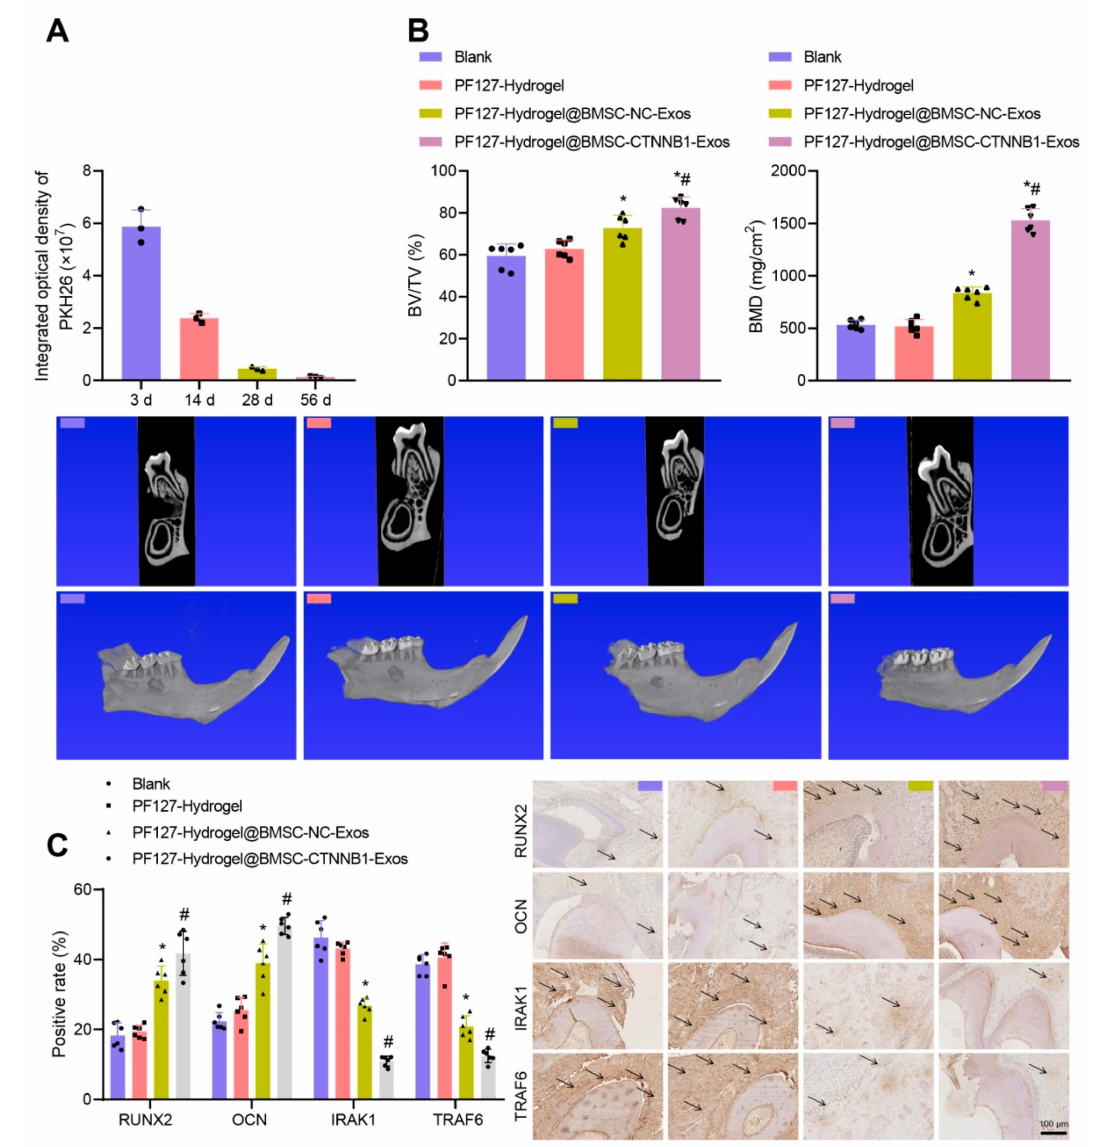
Figure 8. PF127 hydrogel loaded with BMSC-CTNNB1-Exos induces the alveolar bone regeneration in rats. ( A ) In vivo TPEF recording of the distribution of PKH26-labeled Exos implanted at different time points and quantitative analysis. n = 3. ( B ) The micro-CT scanning images focusing on the second mandibular molar (red frame) and the quantitative results of alveolar bone defects in rats treated with PF127 hydrogel@BMSC-CTNNB1-Exos. n = 6. ( C ) The positive expression of RUNX2, OCN, IRAK1, and TRAF6 in new bones detected by immunohistochemical staining. The black arrows indicate dark brown particles, which represent protein positive staining. n = 6. * p < 0.05 vs. the PF127 hydrogel group. # p < 0.05 vs. the PF127 hydrogel@BMSC-NC-Exos